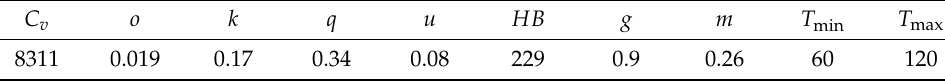
Table 2. Tool life parameters.